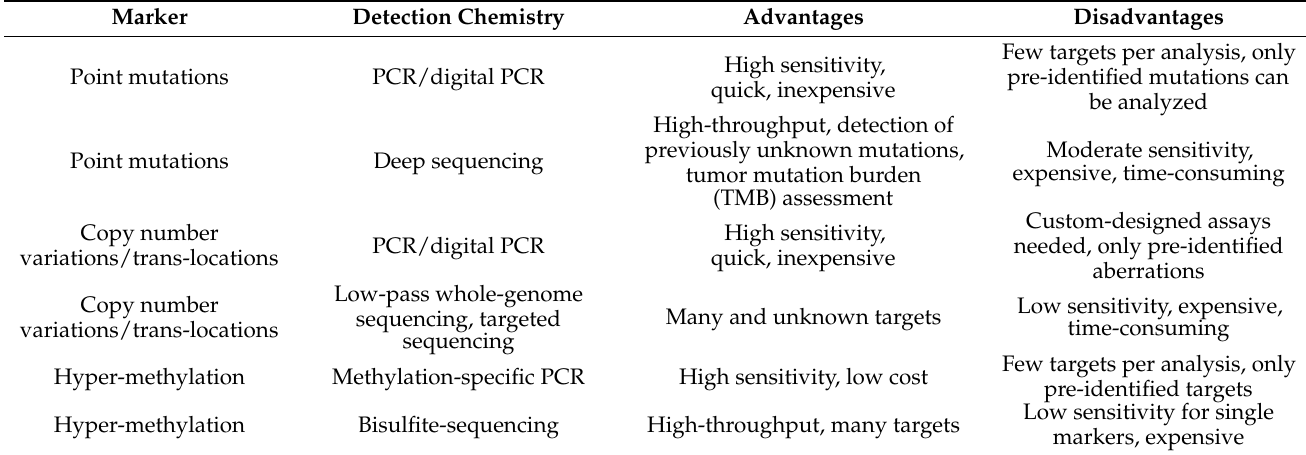
Table 1. ctDNA markers and detection